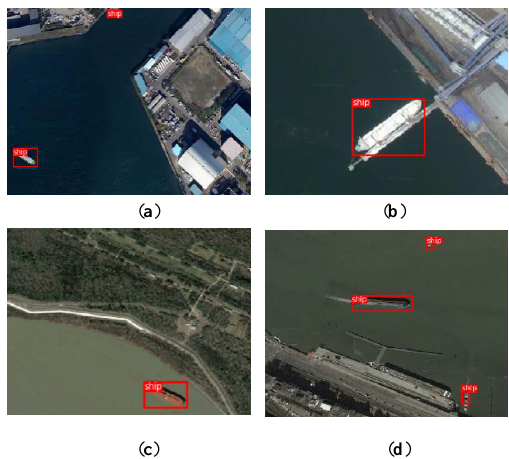
Figure 21. Examples of ship detection results of harbor images containing land. The ships near the shore in the images ( a – c ) are well detected. Three ships were detected in ( d ), but one ship docked on the shore was not detected. There are many interferences when detecting ships in the harbor, and the detection e ff ect is lower than that of ships on the sea.